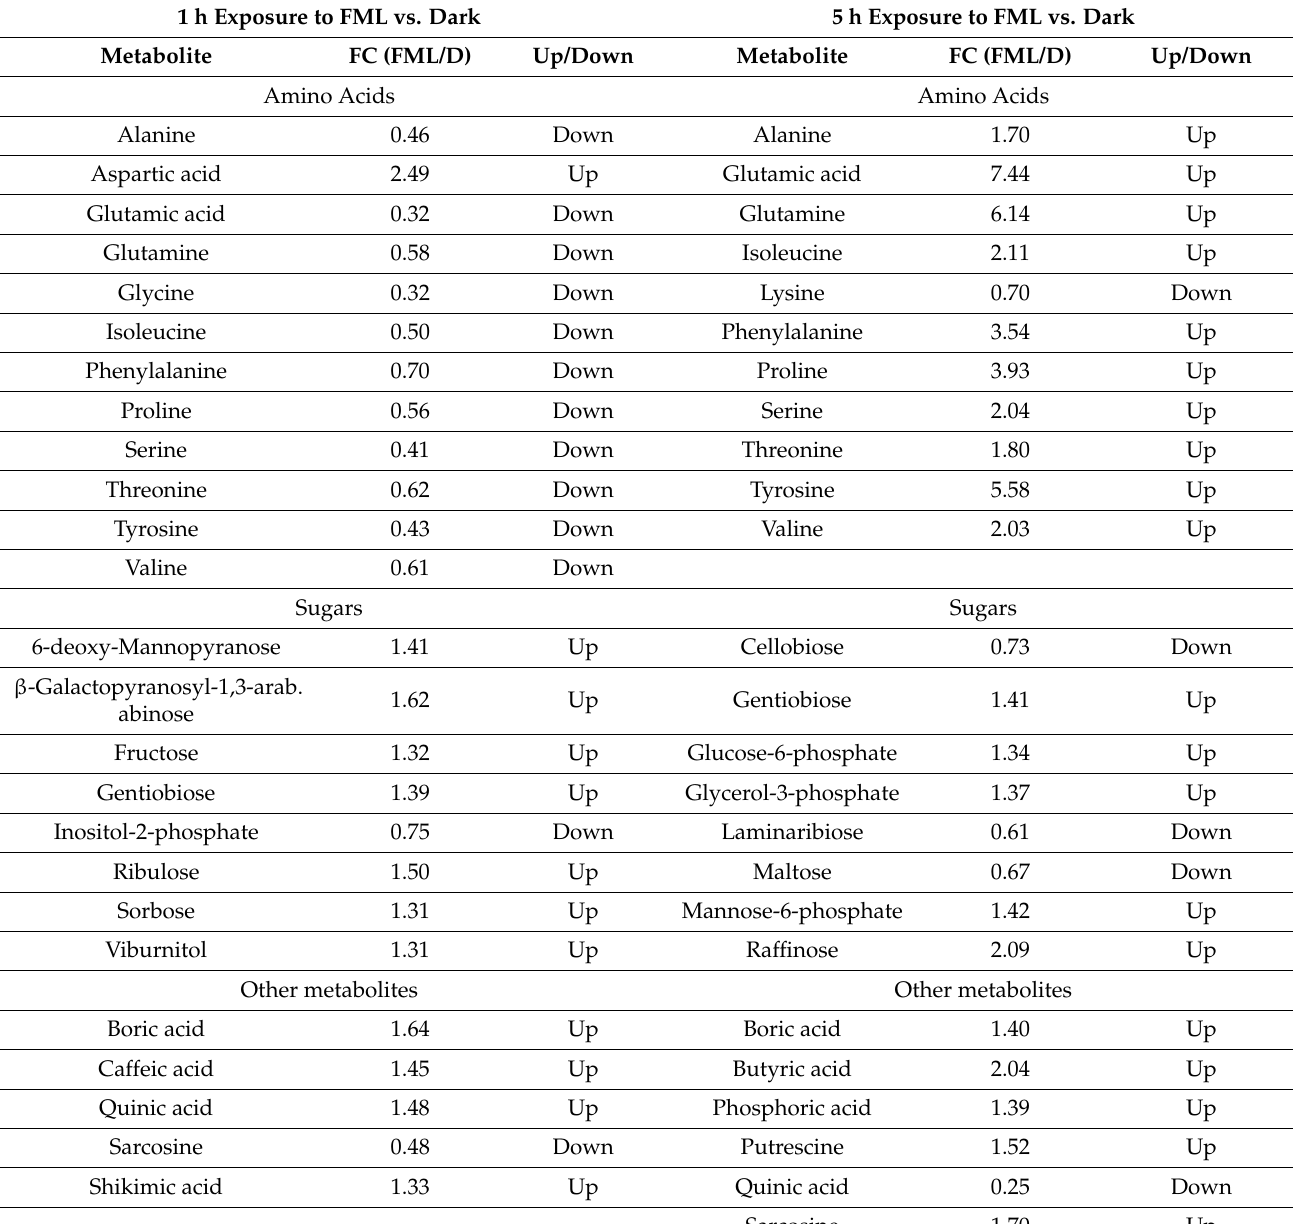
Table 1. A list of differentially expressed metabolites in tobacco leaves after 1 h and 5 h of exposure to FML and the dark. FC, fold change > 1.3 ( p value < 0.05). 1 h Exposure to FML vs.